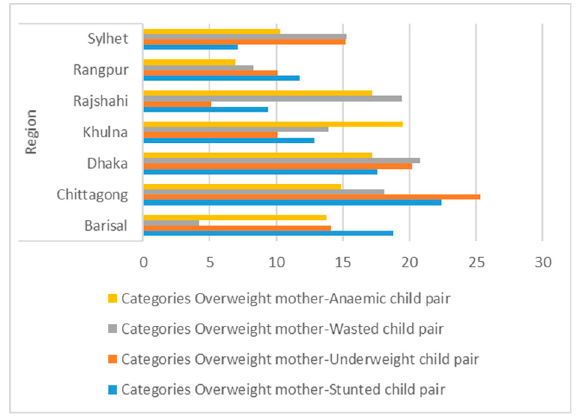
Figure 2. Regional distribution of double burden of malnutrition (DBM).